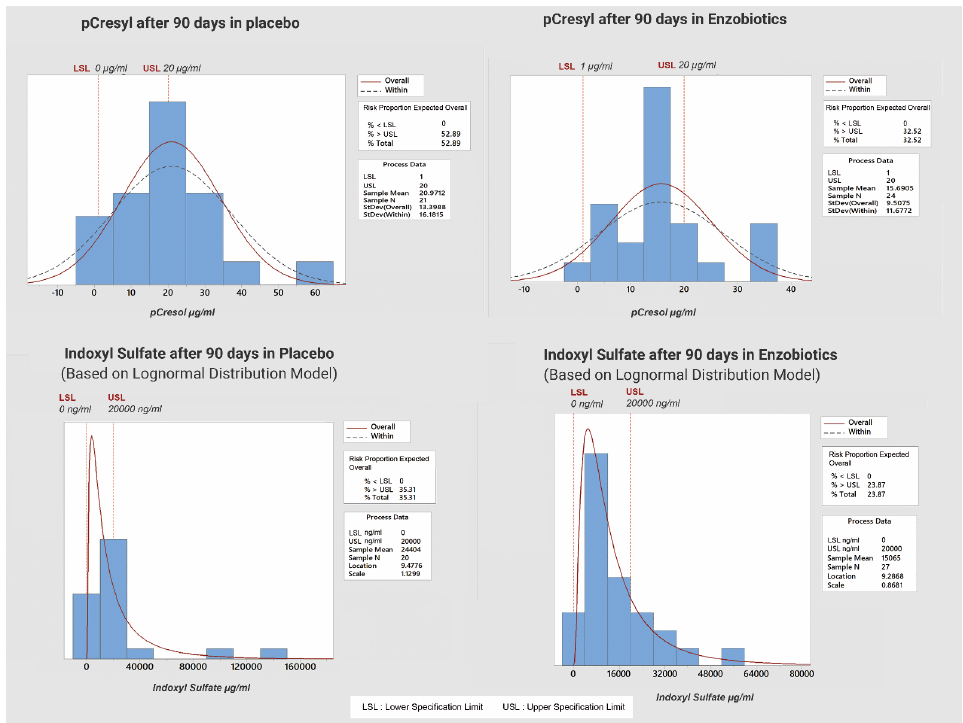
Figure 3. Risk of aggravation of CKD beyond threshold value of PCS and IS (for placebo and enzobiotic groups) on Day 90.